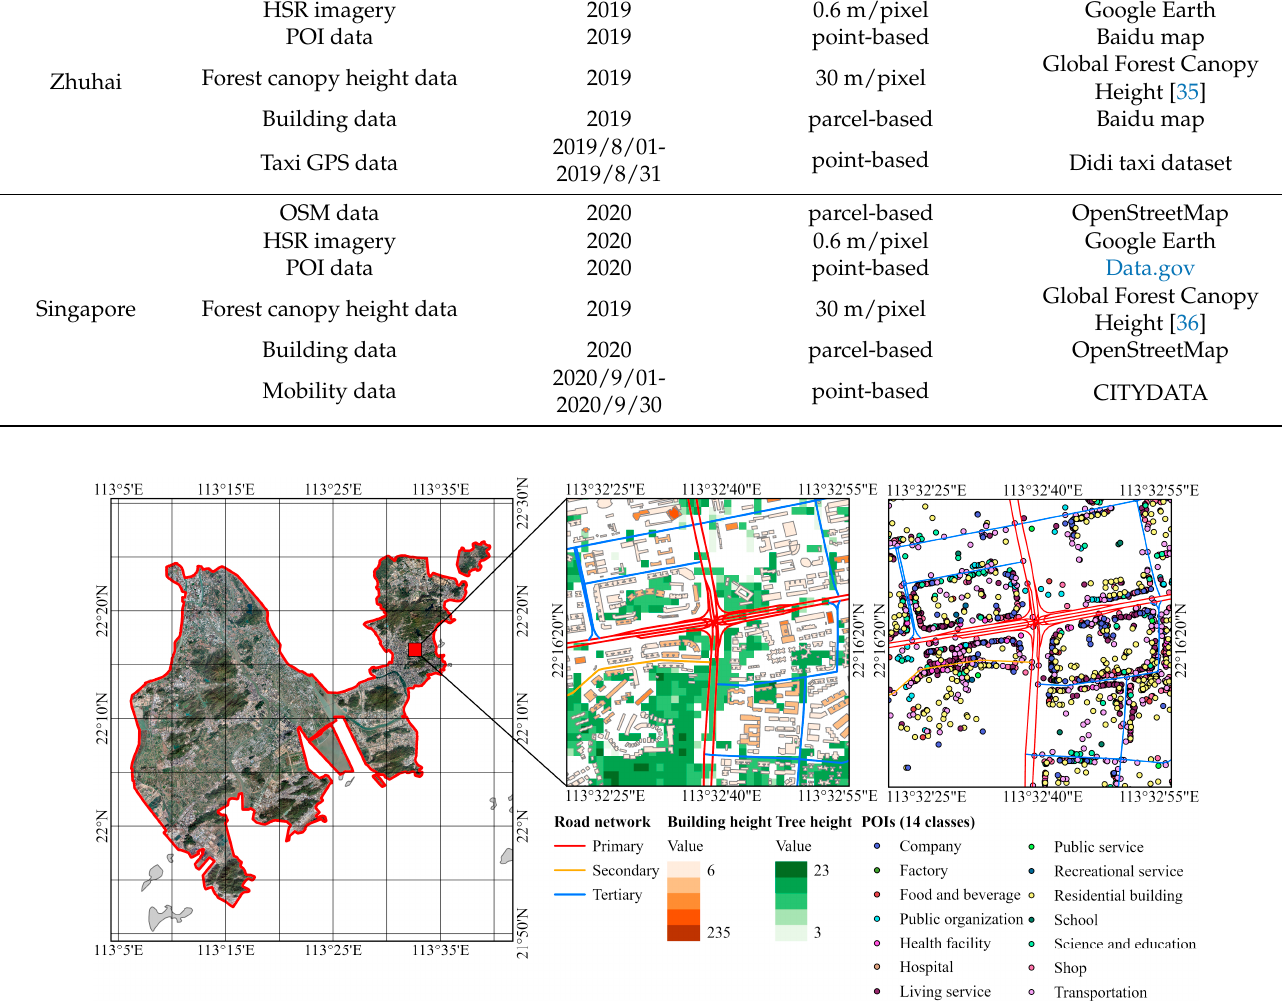
Figure 2. HSR image, road network, building data, forest canopy height, and POIs in Zhuhai.